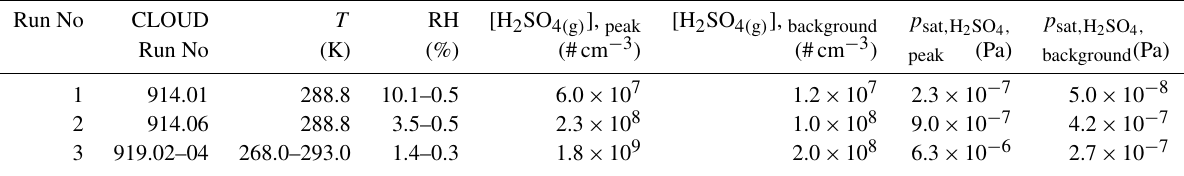
) for each experiment. 2 SO 4